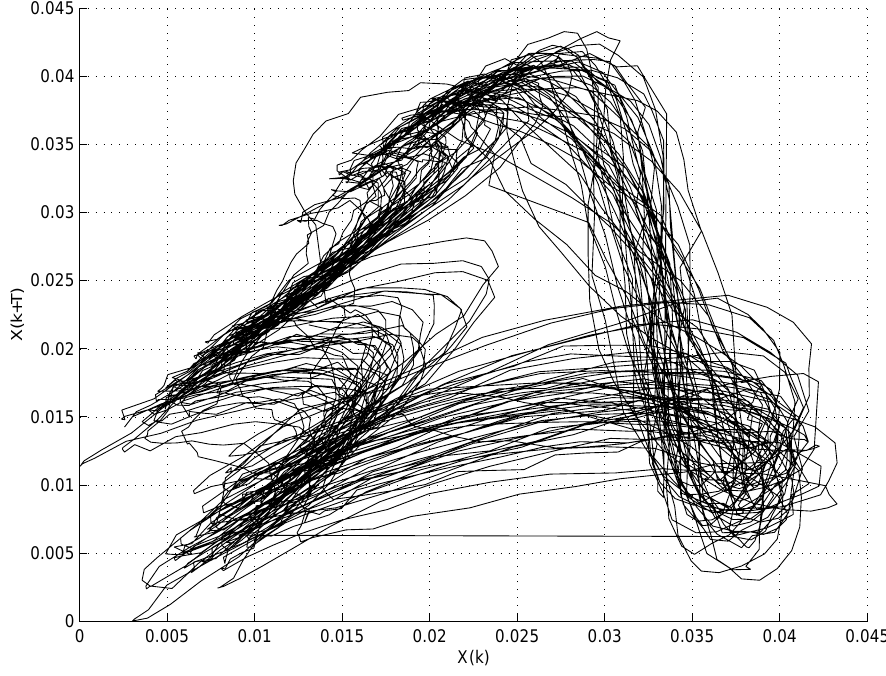
Fig. 10. Reconstructed space state for case 5 without low pass filtering.